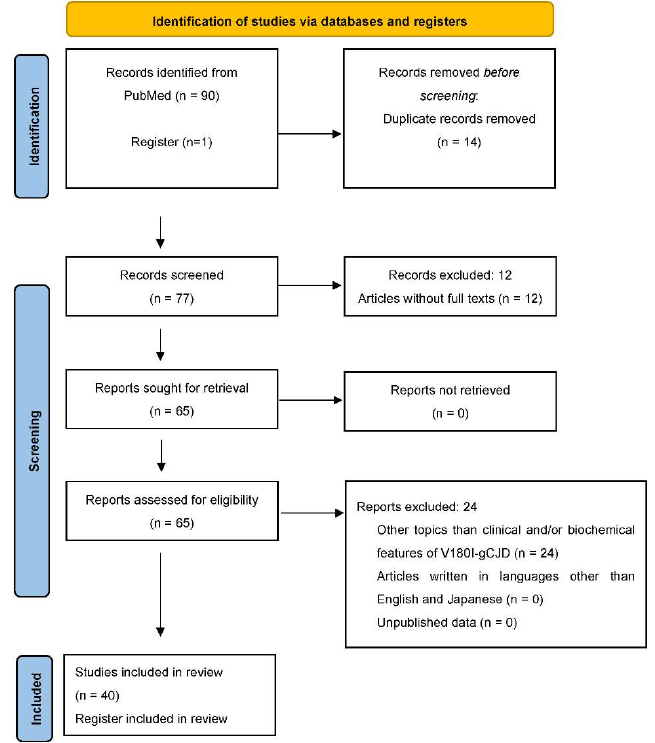
Figure 1. PRISMA flow-chart diagram showing the paper selection process. Table 1. Articles analyzed and referred to in this review.